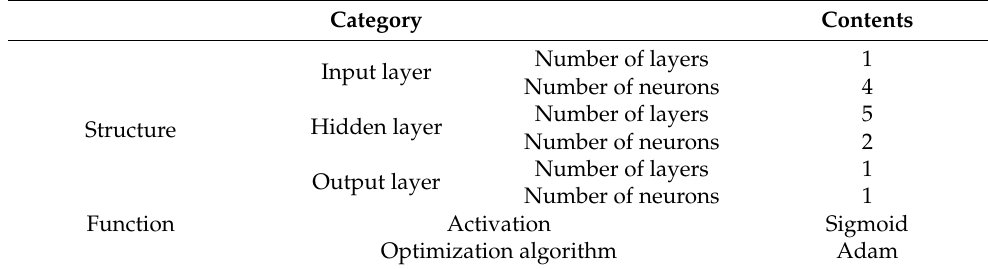
Table 4. Parameter configuration of ANN model.